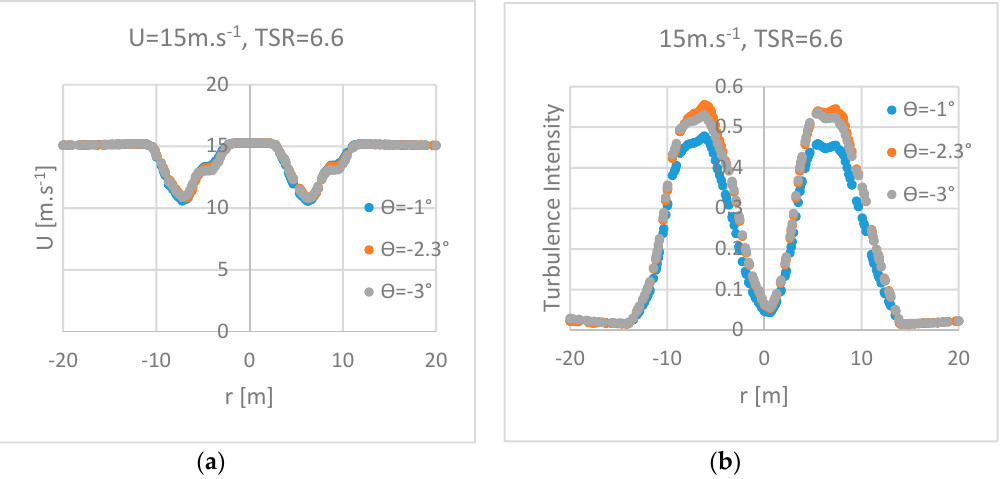
Figure 10. Influence of the pitch angle ( θ ) on the: ( a ) velocity profile at 10D (diameters) downstream the rotor in the wake; and ( b ) TI profile at 10D (diameters) downstream the rotor in the wake.